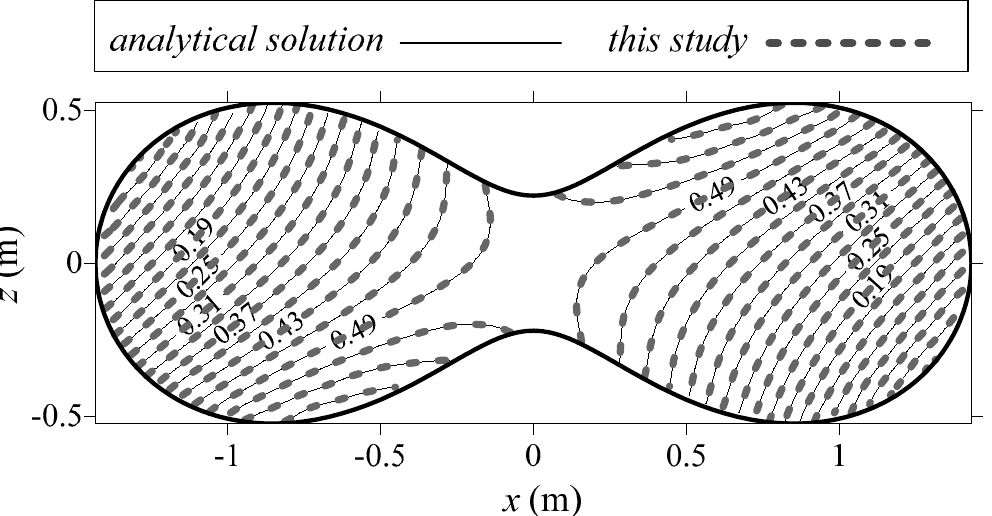
Figure 6. Comparison of the computed head with the exact solution on profile 50 .z =